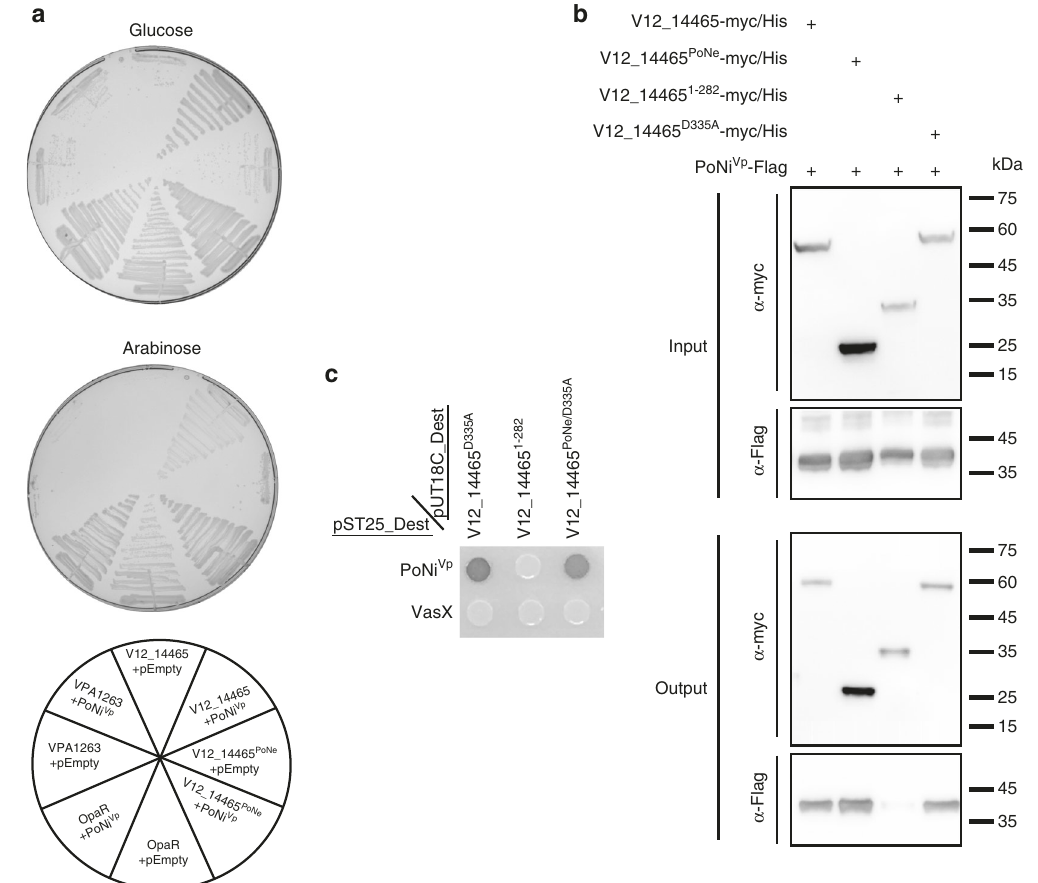
Fig. 3 V12_14460 provides immunity against PoNe domain. a Toxicity of V12_14465 variants expressed in E. coli BL21(DE3) from arabinose-inducible expression plasmid with or without V12_14460 (PoNi Vp ). OpaR, the V. parahaemolyticus high cell density quorum sensing master regulator, was used as a nontoxic control. VPA1263, a T6SS1 effector with a predicted colicin DNase domain, was used as a non-PoNe toxic control. b Ni-Sepharose resin pull-down of myc/His-tagged V12_14465 forms with PoNi Vp -Flag after co-expression in E. coli BL21(DE3). c Bacterial two-hybrid assay. The indicated proteins were expressed in E. coli BTH101 reporter strain fused to the T18 or T25 domain of the Bordetella adenylate cyclase. Bacteria were spotted on plates supplemented with the chromogenic substrate X-Gal. A dark-colored colony indicates protein – protein interaction. The V. cholerae T6SS effector VasX was used as a negative control. PoNi Vp , V12_14460; V12_14465 PoNe , V12_14465(283 – 449); V12_14465 PoNe/D335A , V12_14465(283 – 449/D335A); pEmpty, empty expression vector. Source data are provided as a source data fi N-terminal VgrG or PAAR domain (e.g., V. parahaemolyticus T6SS1 AHH nuclease domain-containing effector VP1415 24 ) (Fig. 4c and Supplementary Data 2). The presence of T6SS-related